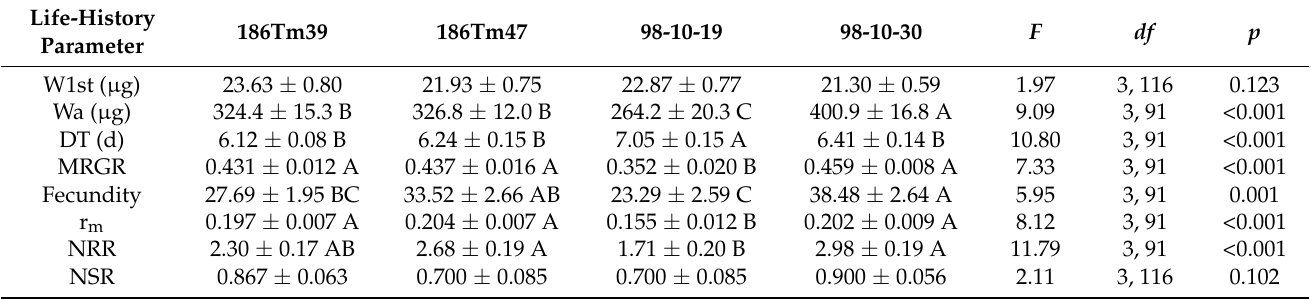
Table 1. The life-history traits of four wheat-acclimated Schizaphis graminum populations (mean ±